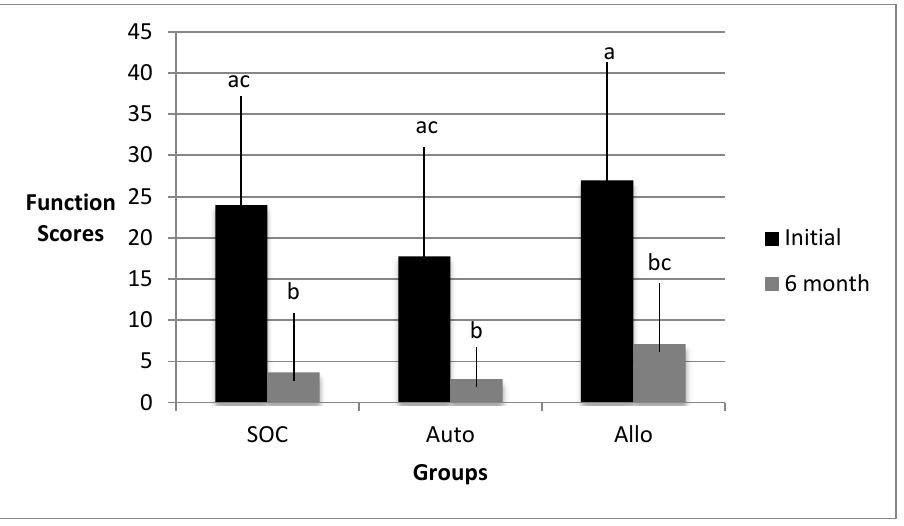
Figure 2: Comparison of function scores between initial and follow-up assessments. Average score of canine brief pain inventory questionnaire for each treatment group’s function score at initial assessment (black), and at 6-month follow-up assessment (grey). The x- axis is each treatment group, and the y-axis is the averaged score of owner assessment of patient function calculated by answering six questions. (0= no interference, 10= completely interferes) The highest (worst) possible score would be sixty. Treatments consisted of standard of care (SOC), autologous (Auto) or allogeneic (Allo) cell therapies. Letters above columns are to distinguish statistical significance. Columns labeled with the same letter indicate no statistical significance between scores. Columns that do not share a common alphabetic letter are p<0.05 and are considered statistically different.